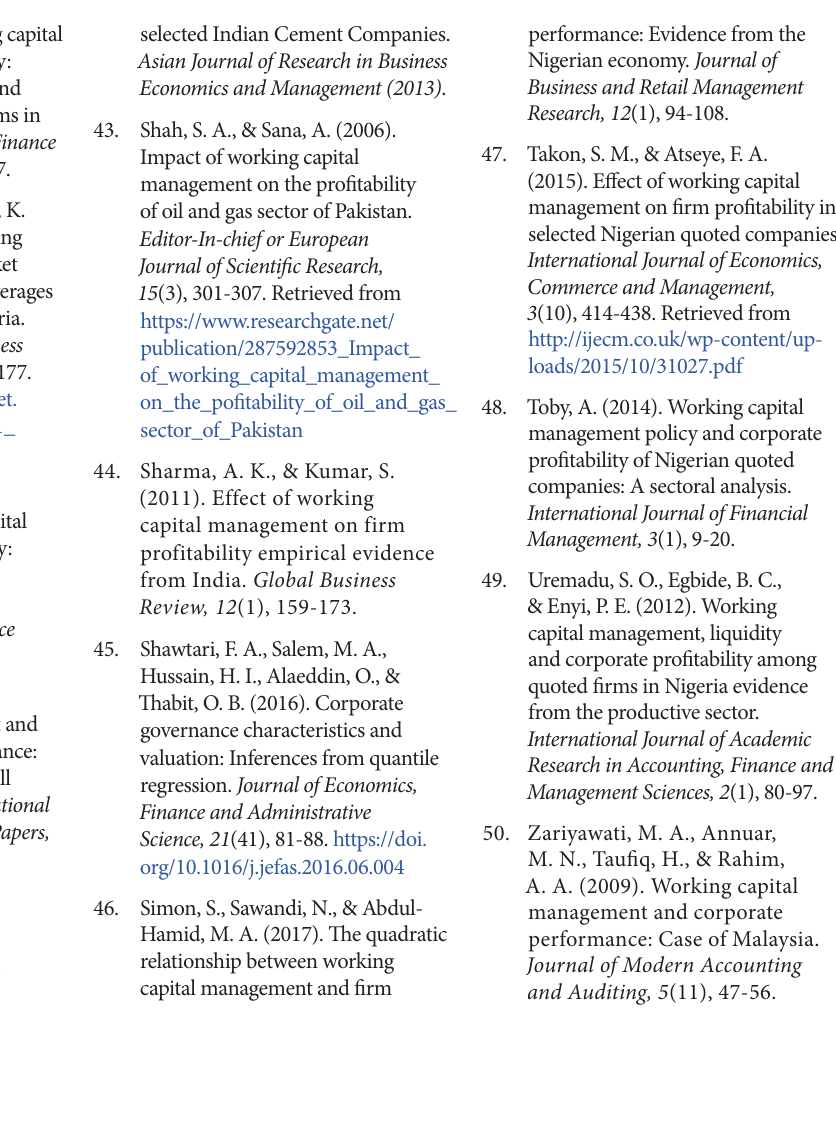
Table A1. Industry classification of a sample Distribution of sample of firms by industry